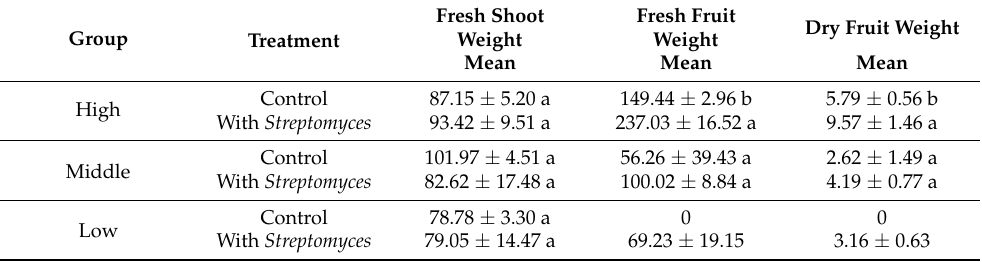
Table 1. Average biomass of cucumber plants in each pot inoculated with or without Streptomyces . Group